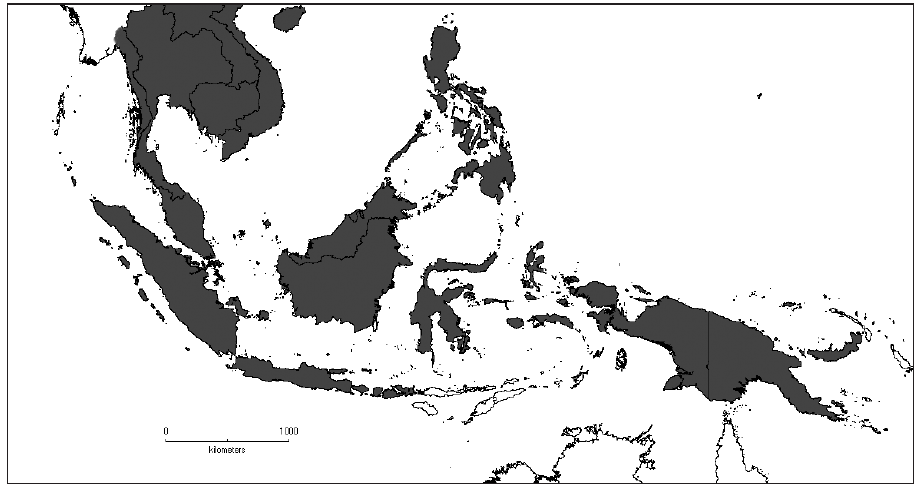
Map 1. Distribution of Dissochaeta